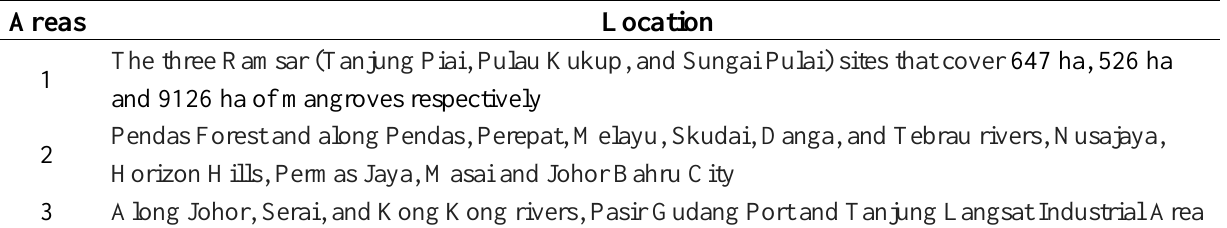
Table 5. Major mangrove sites as shown in Figure 8 in Iskandar Malaysia.